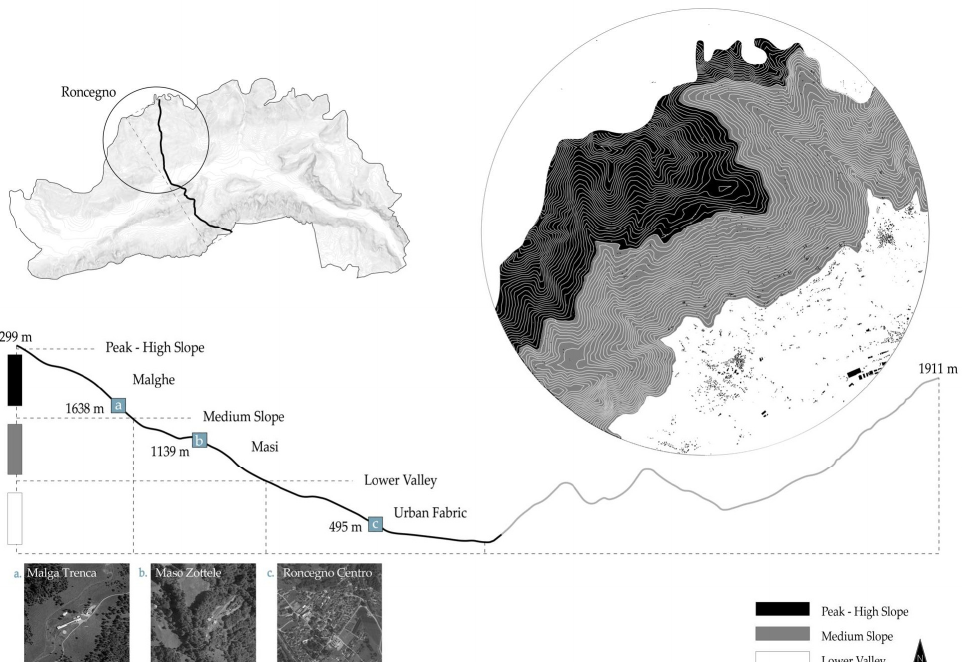
Figure 4. The section shows the three levels that make up the alpine system in the alpine mountains according to the organization of the land in the Latin tradition. According to the historical Latin model, the vertical infrastructure of the landscape is structured based on three nomadically inhabited levels. (1) The first level, including the valley floor, was the site of permanent settlements, crops and meadows. The farming family lived here in the winter with cattle in the stable. (2) The second level, the “maggengo”, was characterized by temporary settlements and meadows. The farming family stayed with the cattle in the spring and autumn for the time required for haymaking operations. (3) The third level, on the peaks, was the alpine pasture or “malga”, where the cattle were driven in the summer season. Each level was equipped with facilities and infrastructure, allowing the community to live and manage the animals and the landscape. This representation is fundamental to understanding the creation of the cultural landscape and the productive, ecological and social significance of alpine pasture systems. The section and the maps represent the territory of Roncegno in the Valsugana Valley, Trentino (© authors